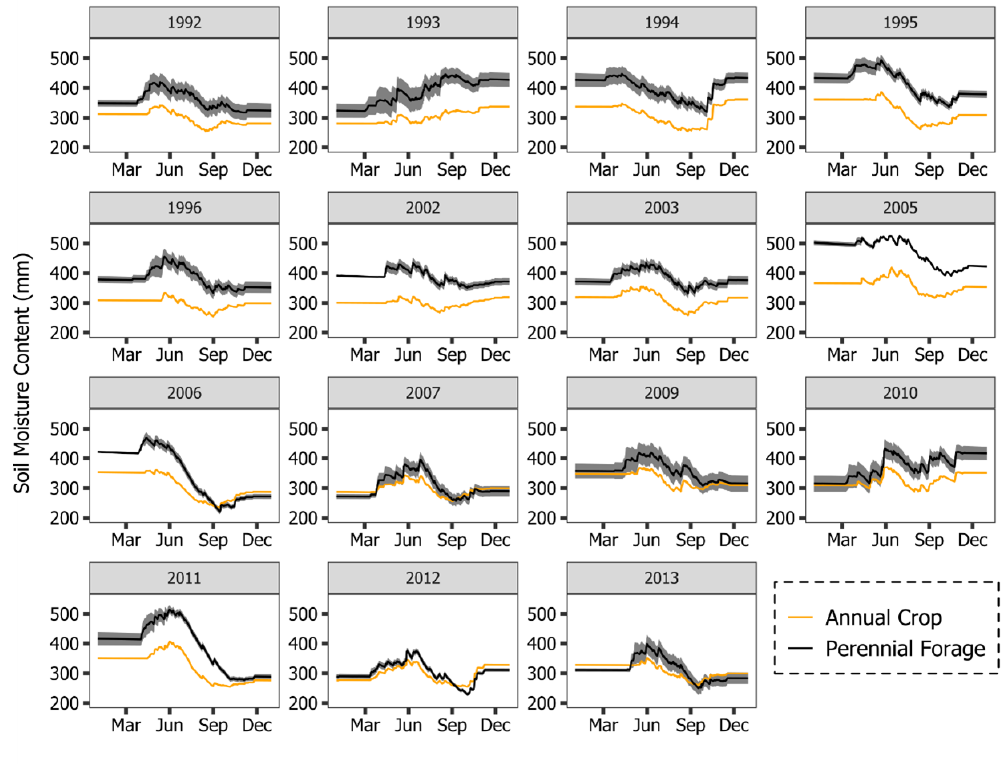
Figure 8. Comparison of soil moisture storage between annual crop model and forage simulations for the La Salle River subbasin (LS- 05OG008). The shaded area indicates the 95% confidence interval of the forage model ensemble. The years 1997–2001, 2004, and 2008 were not used for model assessment due to missing data or equipment